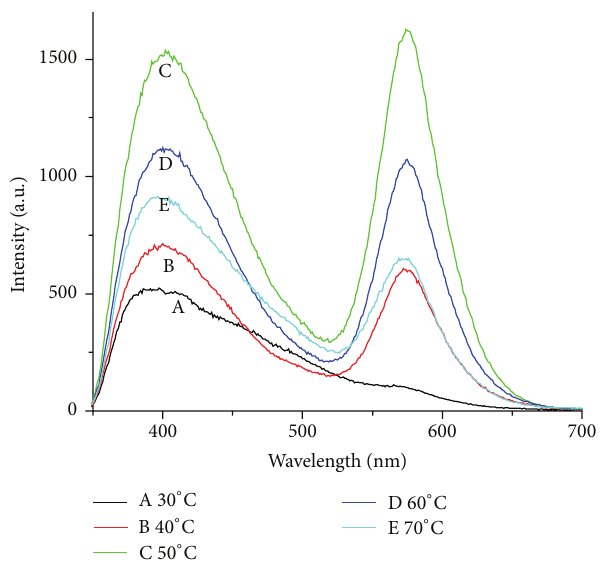
Figure 7: Fluorescence emission spectra of ZnS:Mn 2+ QDs under different reaction times (from 3 h to 5.5 h), obtained using an excitation wavelength of 300